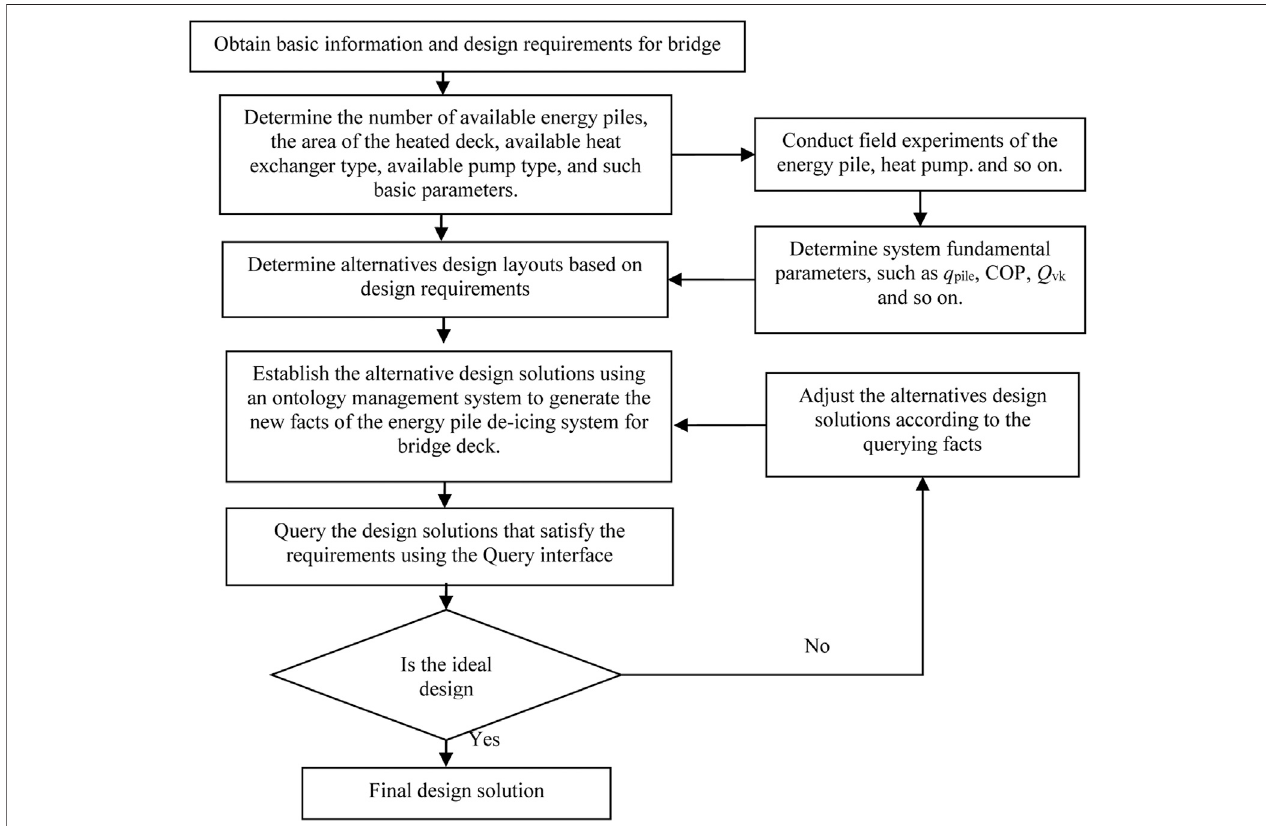
FIGURE 3 | The design fl ow chart of energy pile deicing system for bridge deck using